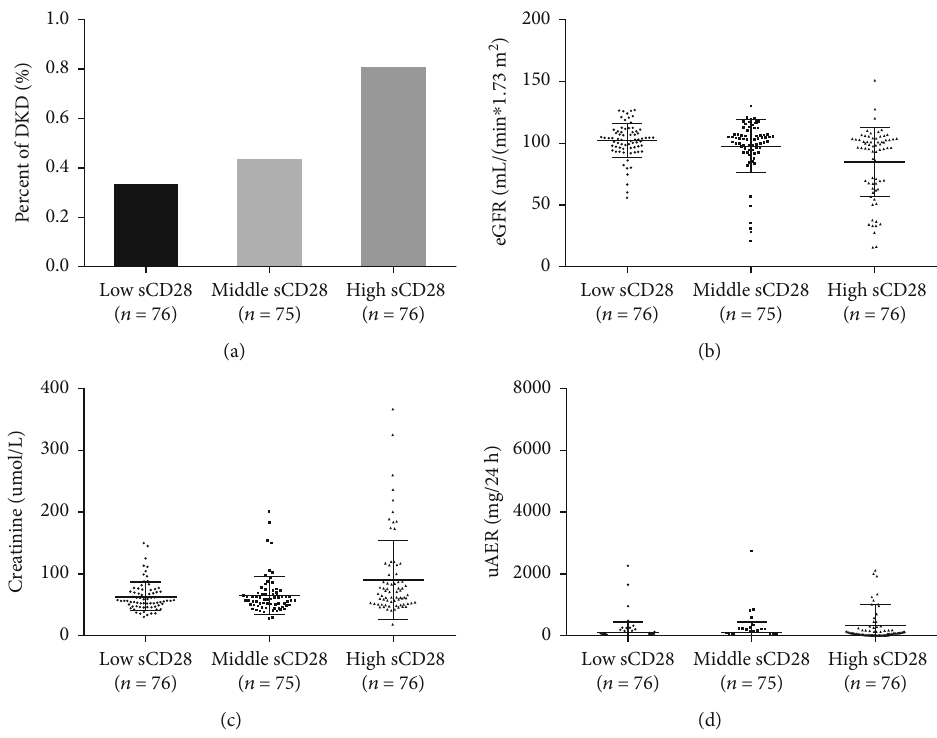
Figure 3: DKD and related traits in patients with T2DM based on di ff erent serum sCD28 levels. Comparison of (a) DKD occurrence ( P < 0 : 0001 ), (b) eGFR ( P < 0 : 0001 ), (c) serum creatinine ( P < 0 : 0001 ), and (d) urinary albuminuria excretion rate trend trend trend < 0 : 0001 ) based on the serum sCD28 tertiles: low sCD28 (0.00-0.48 ng/mL), middle sCD28 (0.49-0.87 ng/mL), and high sCD28 ( P trend values were determined using logistic regression to test dose-response relationships for di ff erent traits according (0.87-5.65ng/mL). P trend to serum sCD28 tertiles.